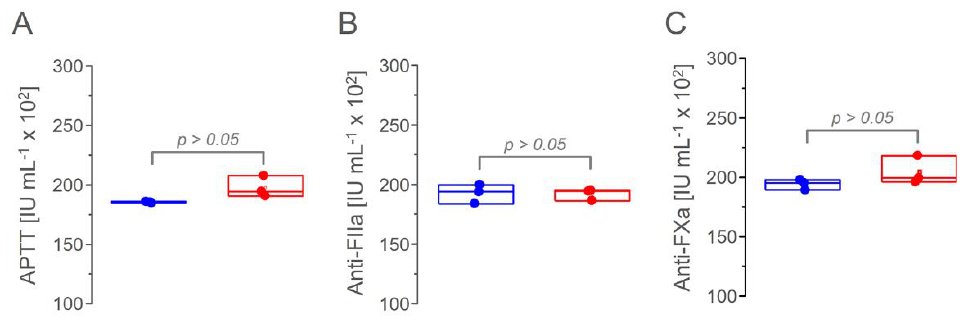
Figure 8. Anticoagulant activity of the pharmaceutical ampules formulated with heparin from man- ufacturers 1 ( blue ) and 2 ( red ) based on APTT (Panel ( A )), anti-FIIa activity (Panel ( B )) and anti-FXa activity (Panel ( C )) assays. anti-FXa activity (Panel ( C ))